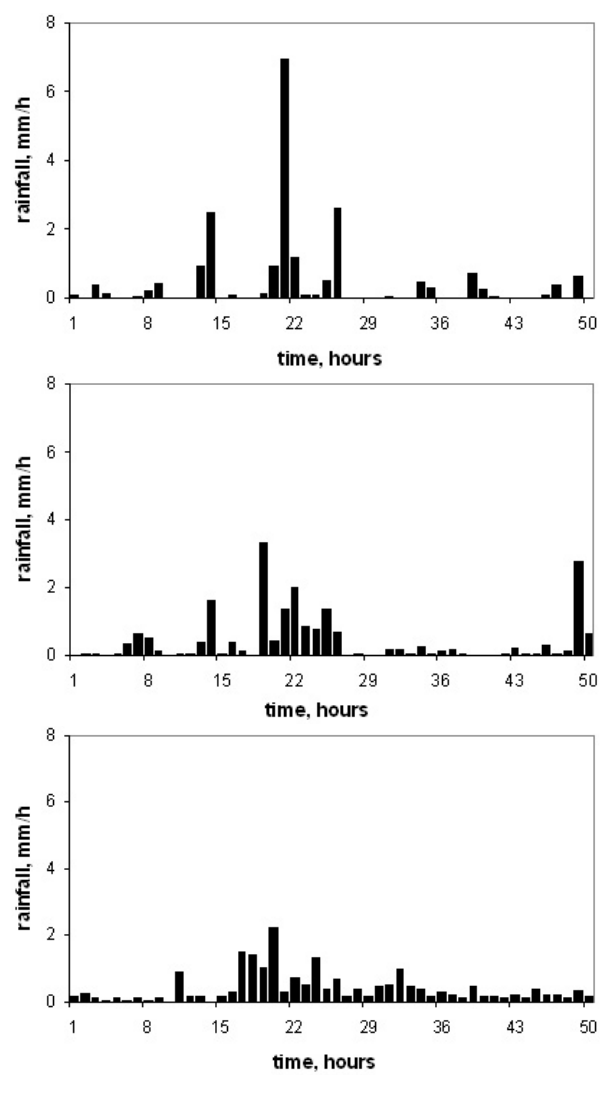
Fig. 1. The variability of individual storms in the rainfall time series for (a) η =0.5, (b) η =1.5 and (c) η =3.0.